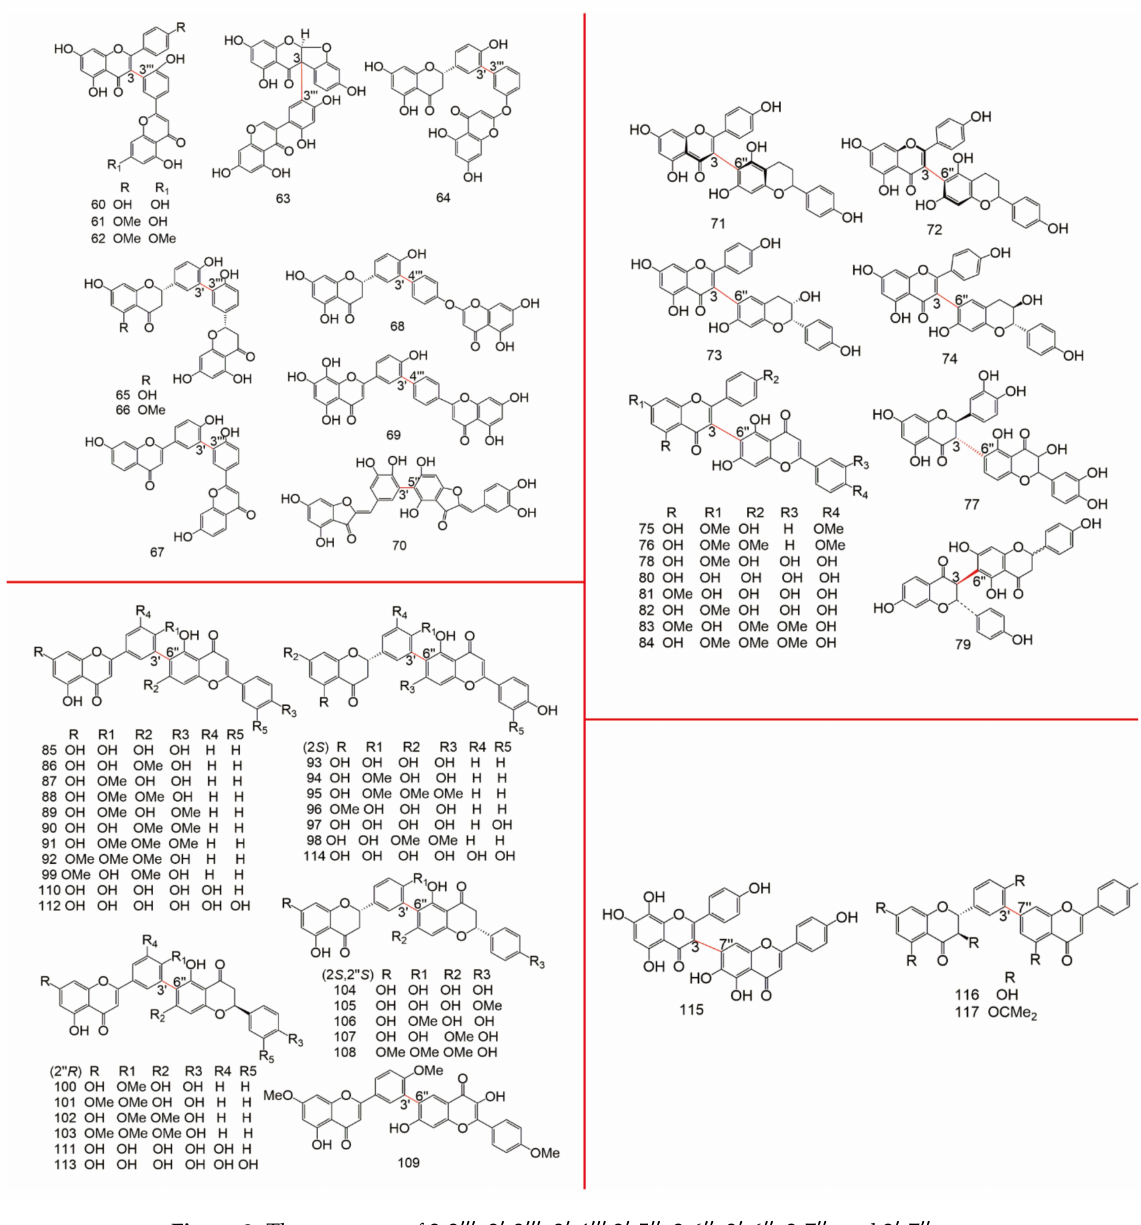
Figure 3. The structure of 3-3 (cid:48)(cid:48)(cid:48) , 3 (cid:48) -3 (cid:48)(cid:48)(cid:48) , 3 (cid:48) -4 (cid:48)(cid:48)(cid:48) ,3 (cid:48) -5 (cid:48)(cid:48) , 3-6 (cid:48)(cid:48) , 3 (cid:48) -6 (cid:48)(cid:48) , 3-7 (cid:48)(cid:48) , and 3 (cid:48) -7 (cid:48)(cid:48) type. The data of 3-8 (cid:48)(cid:48) type biflavonoids were showed in Table 3, the structure of them were drew in Figure